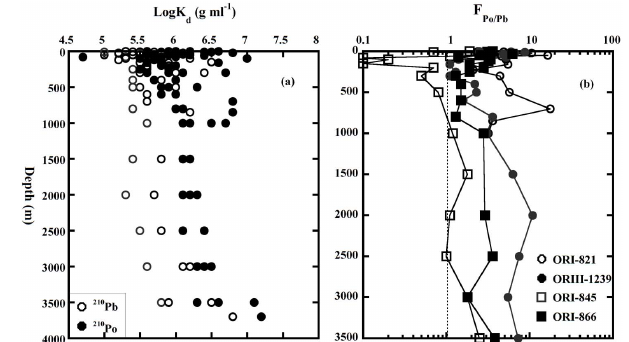
Fig. 7 Figure 7. Vertical profiles of (a) K d (Pb) and K d (Po) and (b) frac- tionation factor of 210 Po and 210 Pb. Dashed line at unity indicates the same partitioning of dissolved and particulate phases for 210 Po and 210